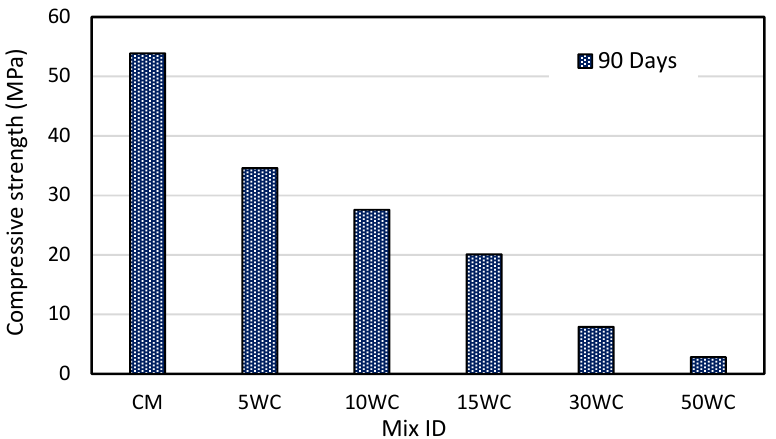
Figure 10. Destructive compressive strength at 90 days.